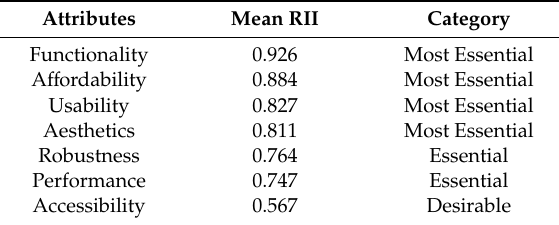
Table 7. Mean RII values and corresponding categories.